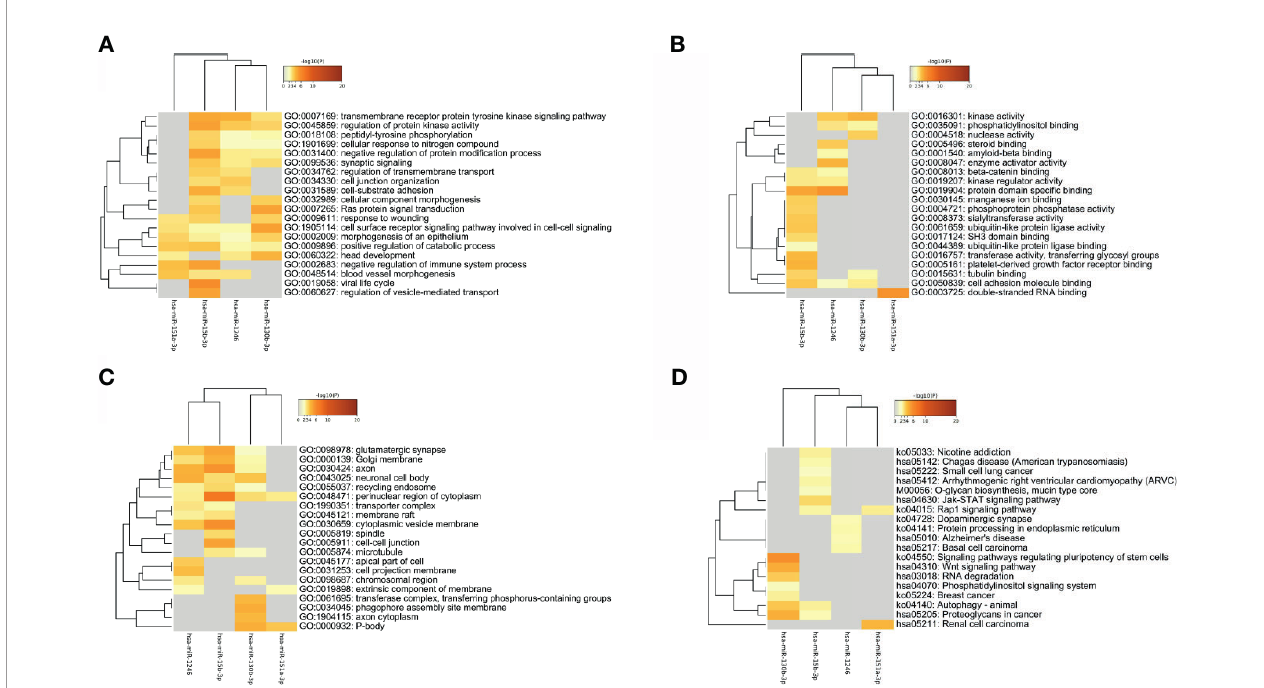
FIGURE 6 | The heatmap of the enriched GO terms and KEGG pathways based all the common targets of the four key DEmiRNAs. (A) Biology Process. (B) Molecule Function. (C) Cellular Components. (D) KEGG pathway.